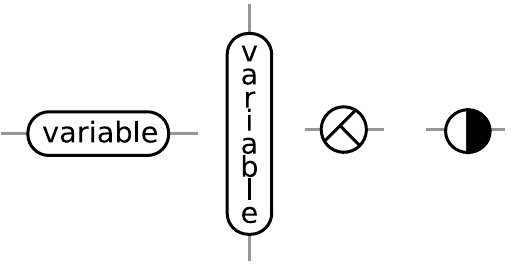
Figure 2.34: The Entity Relationship glyph for state variable . From left to right, horizontal state variable , vertical state variable , location , existence